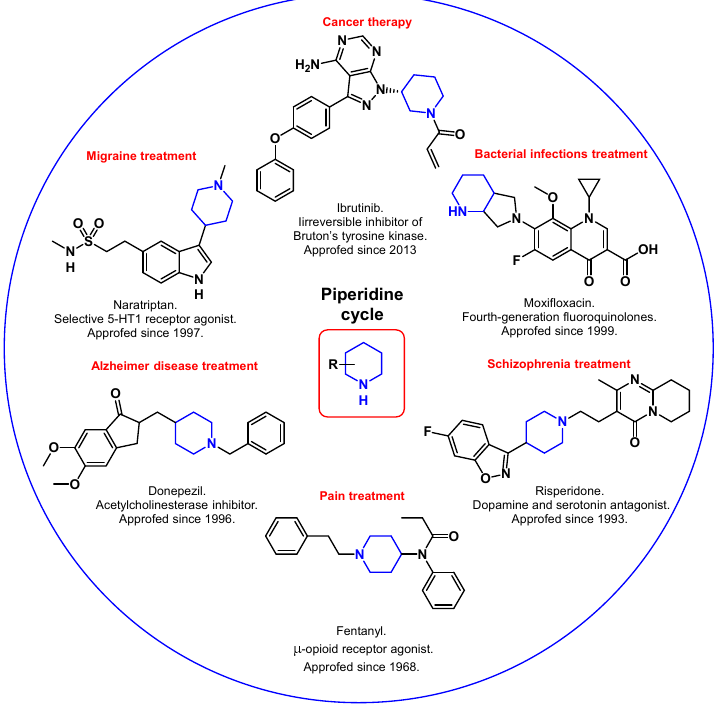
Figure 3. Synthetic piperidine derivatives in medicine.